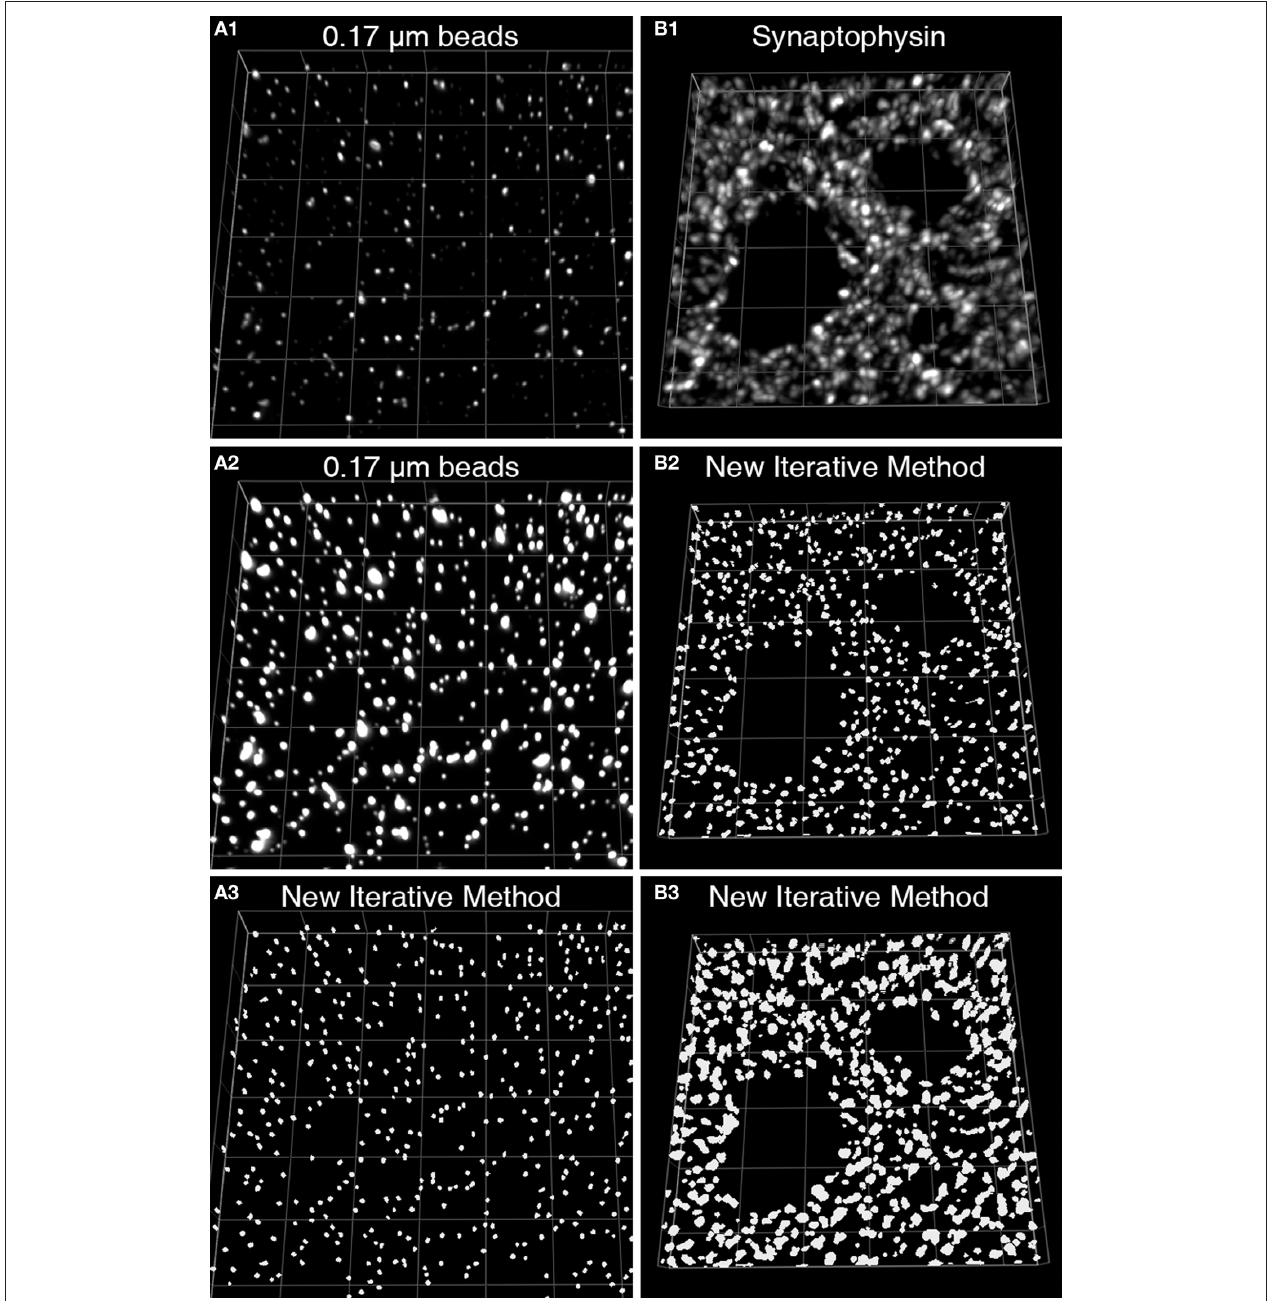
monkey DLPFC section labeled for synaptophysin after deconvolution. This data set underwent iterative segmentation with objects selected by size using a range